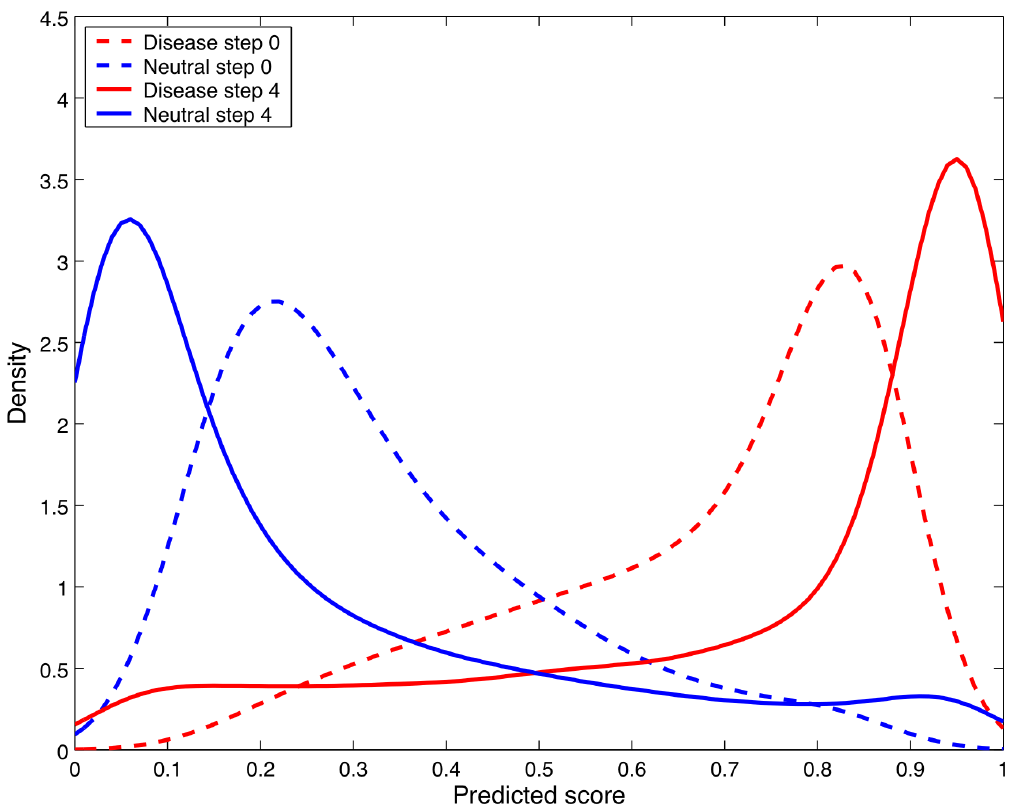
Figure 1. Softening of target values procedure. Density plot showing the change in the distribution of the output values for known disease and neutral SNPs in the running evaluation set during the softening of target values procedure. Step 0 is the distribution of output values before the procedure and step 4 is the distribution at the end of the procedure for the final version of NetDiseaseSNP. Predicted scores above the threshold of 0.5 are true positives for data shown in red graphs, whereas scores above 0.5 in the blue graphs represent false positives. It is seen that predicted scores are dragged more to the extreme ends (0–1) after applying the procedure ‘softening of target values’.